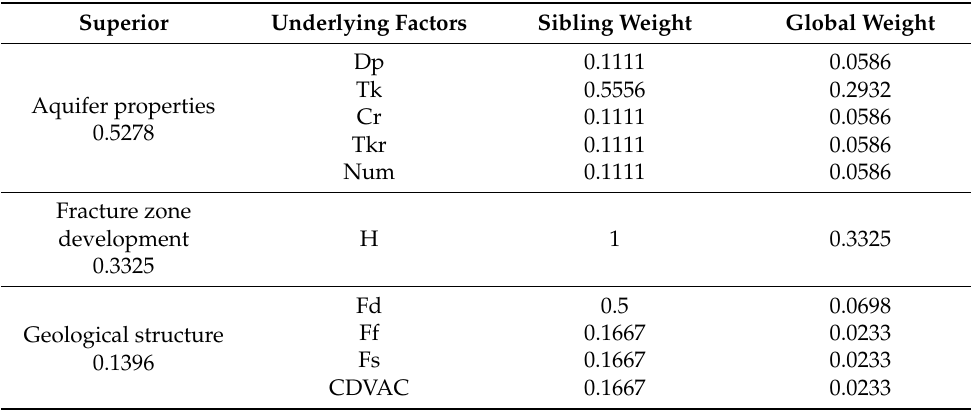
Table 2. The weight of each evaluation index based on the AHP